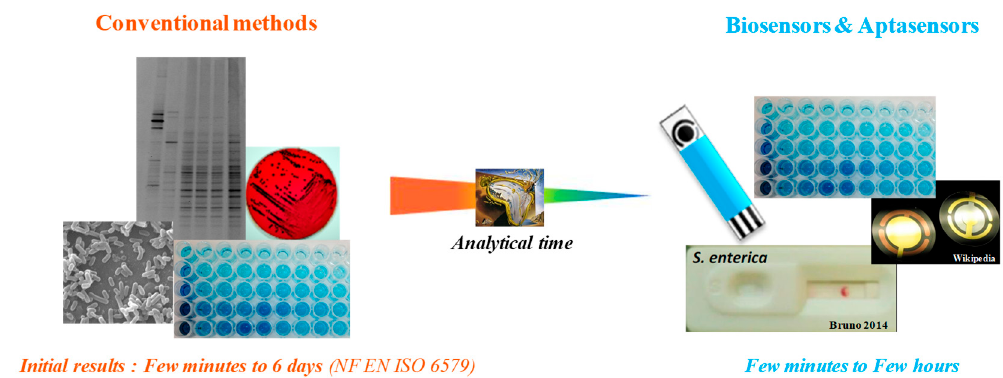
Figure 3. Comparison of the analytical time of the conventional methods versus the biosensors and the aptasensors for the detection of foodborne bacteria.